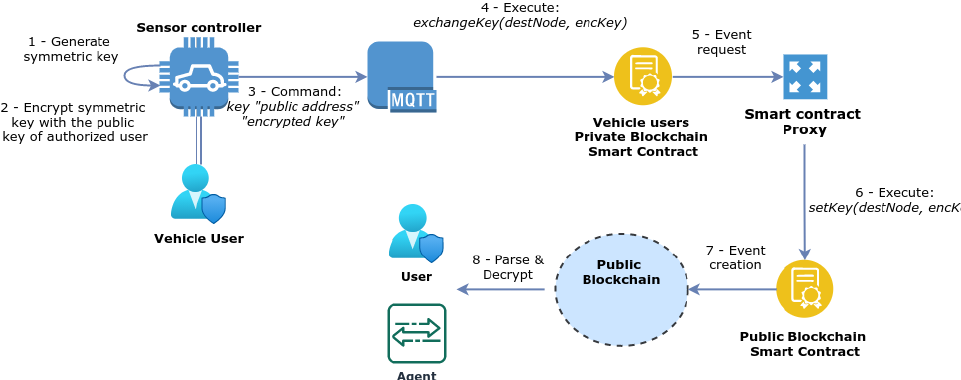
Figure 4. Exchange of the symmetric key with authorised